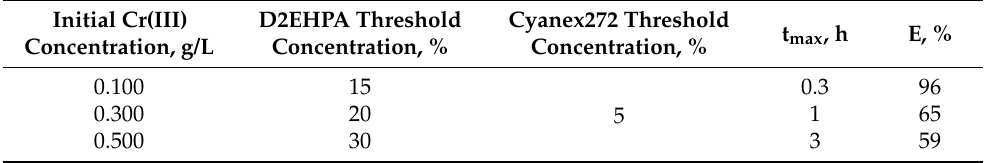
Table 7. Selected Cyanex272 threshold concentrations and time of the maximum Cr(III) ion